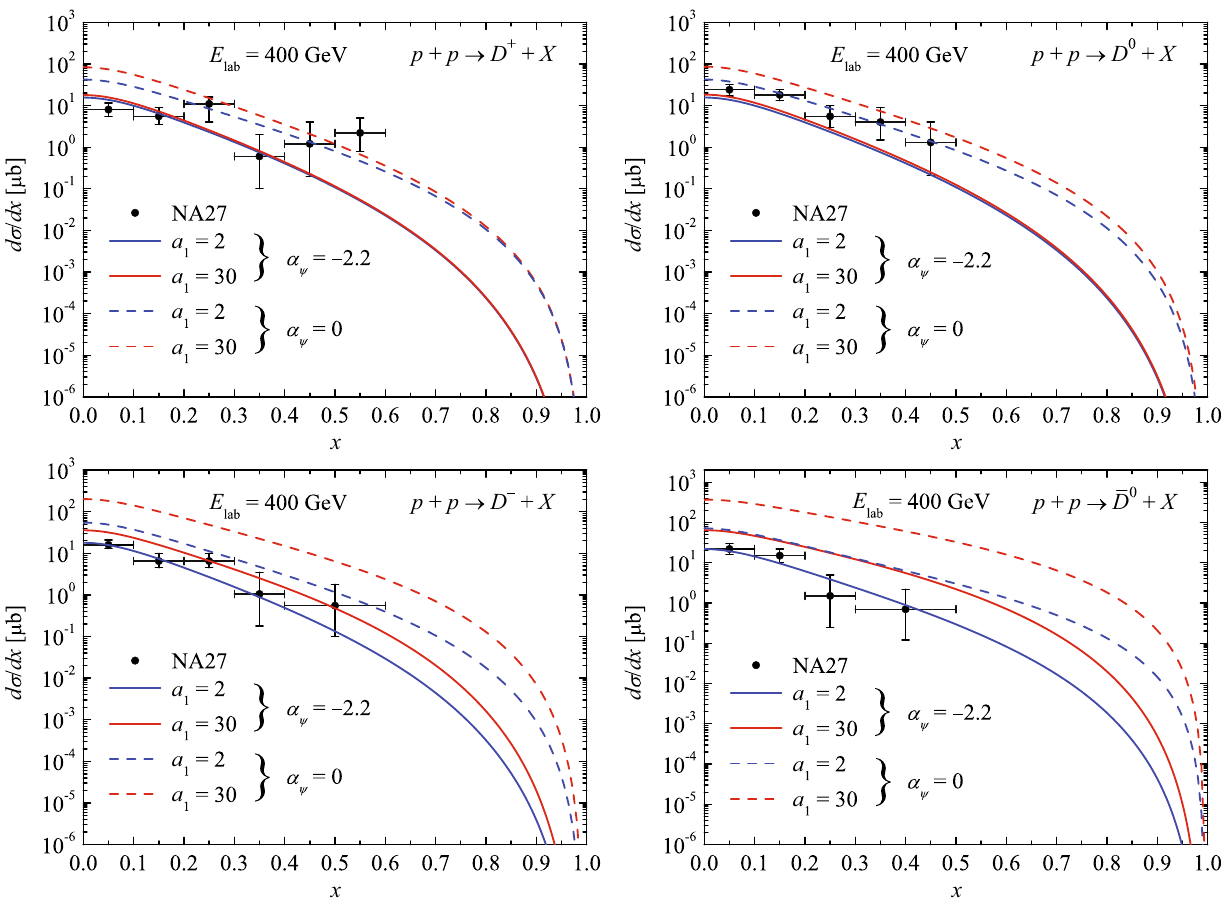
Fig. 3 Differential cross sections of each type of D mesons ( D + , D − , D 0 , ¯ D 0 ) production in pp collisions at E lab = 400 GeV. Lines plot the result of QGSM calculations with α ψ ( 0 ) = − 2 . 2 (solid lines) and α ψ ( 0 ) = 0 (dash). Experimental data are from [40]